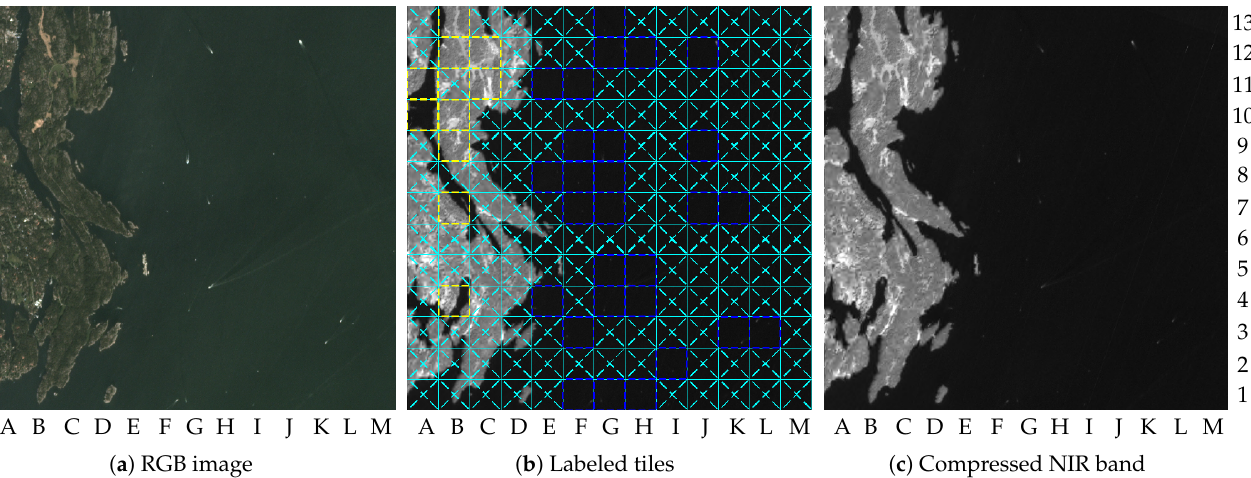
Figure 9. Results for image 2: ( a ) RGB image (truncated at 2000); ( b ) labeled tiles (truncated at 4000); ( c ) compressed NIR band (truncated at